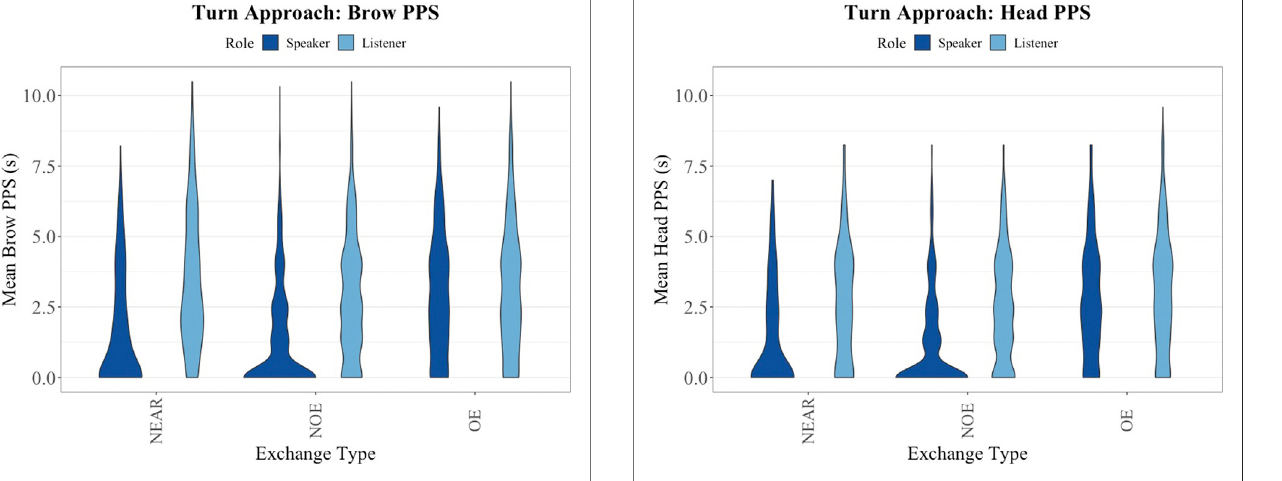
FIGURE 6 | Turn Approach brow PPS summary by exchange type and role.